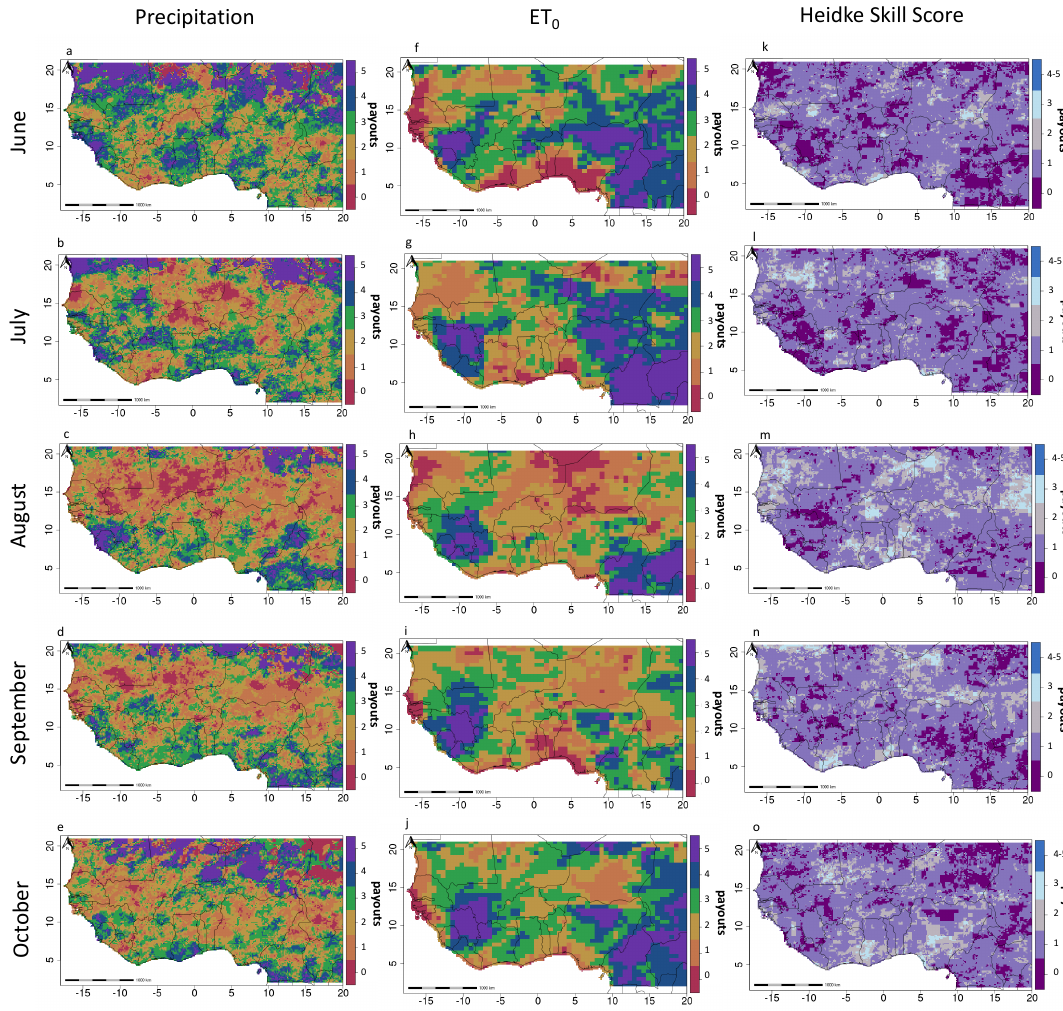
Figure 6. ( a – e ) (Left, Top to Bottom) June ( a ), July ( b ), August ( c ), September ( d ), October ( e ) payouts that occurred for 1999–2016 precipitation data. ( f – j ) (Middle, Top to Bottom) June ( f ), July ( g ), August ( h ), September ( i ), October ( j ) payouts that occurred for 1999–2016 ET 0 data. ( k – o ), (Right, Top to Bottom) June ( k ), July ( l ), August ( m ), September ( n ), October ( o ), Heidke Skill Score for the payouts of ET 0 to the precipitation payouts. These plots show where the precipitation data and the ET 0 data have between 0 and 5 payouts occurring in the same year. To match the ET 0 and precipitation grids, the precipitation data were averaged per-pixel and resampled using nearest-neighbor. However, although some areas in the ET 0 appear more coarsely mapped than the precipitation data or the Heidke Skill Score maps, this appearance is a known consequence of the method in https: //psl.noaa.gov/eddi/globalrefet/ used to downscale the ET 0 spatial resolution from 0.5 ◦ × 0.625 ◦ resolution to 0.125 ◦ to 0.125 ◦ × 0.125 ◦ resolution and is not an artifact in our analysis in this